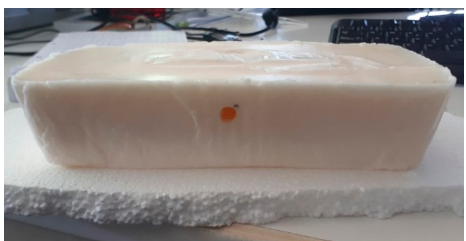
Figure 6. Picture of the produced phantom ( Phantom3 ) used for mm-wave imaging, in which the inclusion is visible.